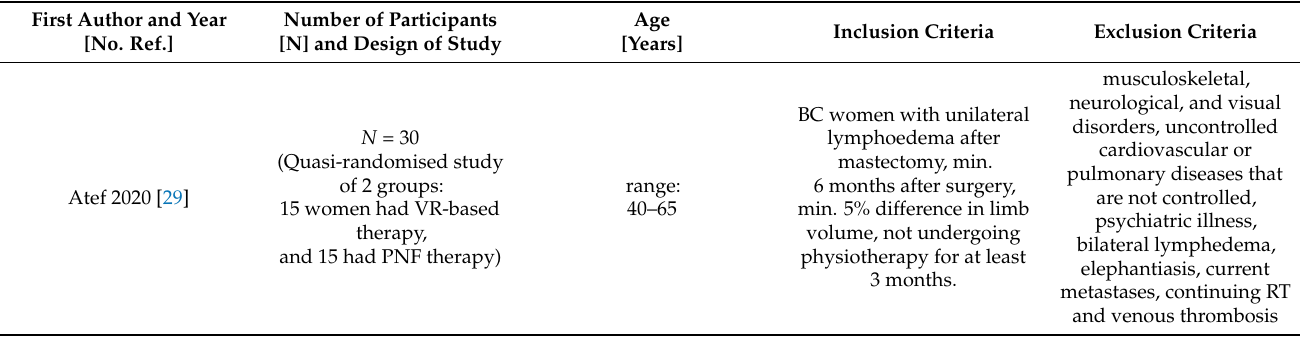
Table 2. Characteristics of the participants of the included studies.